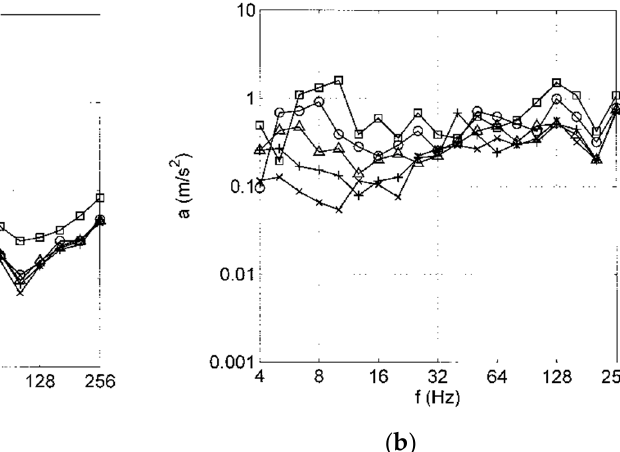
Figure 1. ( a ) Measurement points of the railway vehicle (passenger car) for the test runs, axle boxes A1, A2, bogie B1 and B2, carriage C1 and C2, right hand side, A3, A4, B3, B4, C3, C4 symmetrically on the left hand side; ( b ) one-third octave band spectra of the accelerations of the railway vehicle running with v T = 160 km/h, , wheelset A1 and A2, , vertical bogie part B1 and B2, horizontal bogie part B1, , car body part C1 and C2; ( c ) particle velocities of the track , left and right rail, , sleeper 1 and 2, , sleeper horizontal, sub soil at 2.5 m distance.